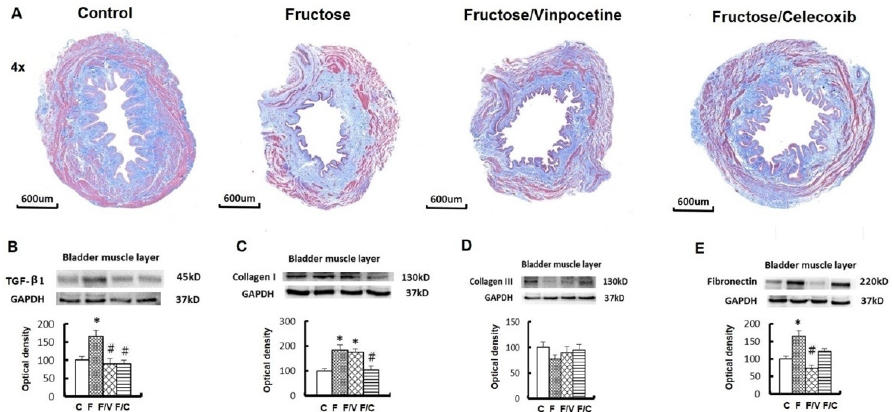
Figure 5. Urinary bladder fibrosis and fibrogenesis markers in experiment groups. ( A ) Masson’s trichrome stain of bladder sections in different groups. The fructose-only group presents obvious submucosal fibrosis. Western blots of fibrogenesis markers in the bladder, including TGF- β 1 ( B ), collagen I ( C ), collagen III ( D ), and fibronectin ( E ). Data are expressed as mean ± SEM. n = 8. * p < 0.05 versus controls and # versus fructose group.